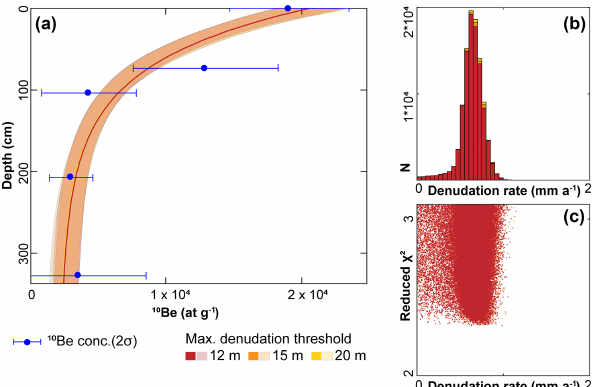
Figure A1. Analysis of cosmogenic 10 Be at site EW-01. (a) Mea- sured 10 Be concentrations plotted against the Monte Carlo (MC) so- lution space (light colors) and the best-fit profiles. (b) Denudation rate histogram from the MC modeling for 10 5 model profiles and (c) corresponding reduced chi-square ( χ 2 ) values. Different model setup results are superimposed (for discussion see